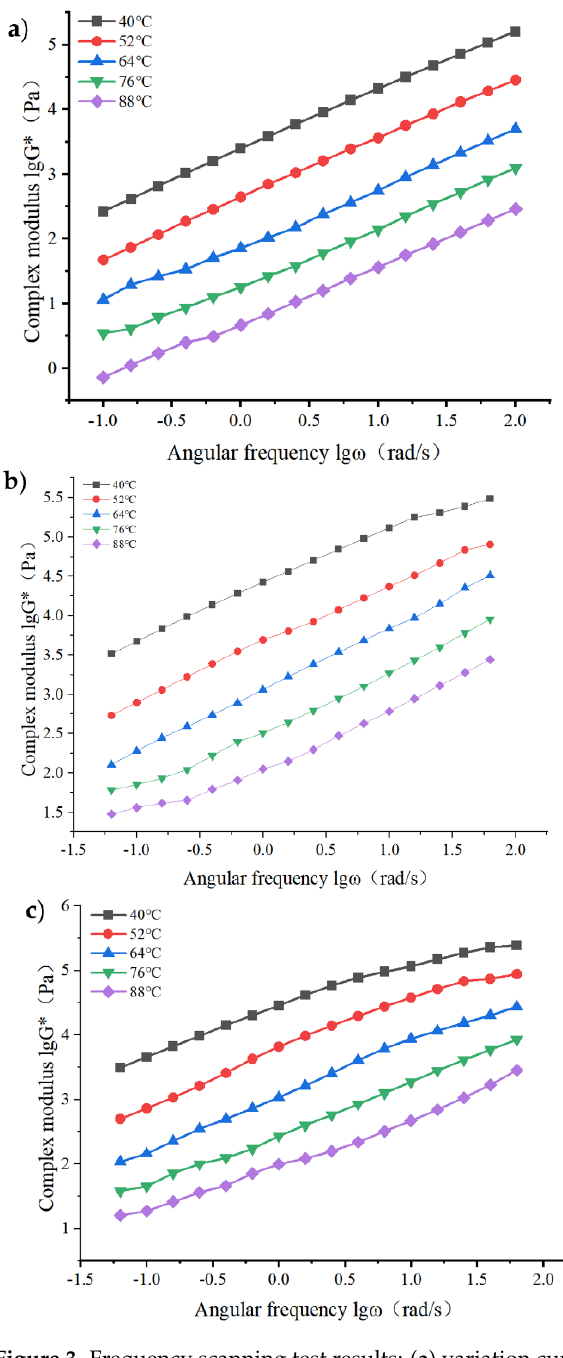
Figure 3. Frequency scanning test results: ( a ) variation curve of complex modulus of matrix asphalt; ( b ) variation curve of complex modulus of matrix asphalt; ( c ) variation curve of complex modulus of GO and rubber powder composite-modified asphalt.